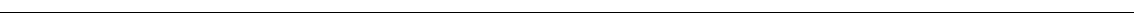
Fig. 5 USP21 stabilizes BRCA2 in HCC cells to promote tumor cell growth. a Western blot analysis of the indicated proteins in the HuH1 hepatoma cell line in the presence or absence of USP21 knockdown. b Western blot analysis and clonogenic survial of HuH1 cells in the presence or absence of BRCA2 knockdown. Colony formation was scored in triplicate and normalized to sh-Luc. Values are expressed as mean and s.d. c Clonogenic survival of HuH1 cells in the presence or absence of USP21 knockdown. Colony formation was scored in triplicate and normalized to sh-Luc. Values are expressed as mean and s.e.m. from three independent experiments. d HuH1 oncosphere formation in the presence or absence of USP21 knockdown. Sphere formation was scored in triplicate and normalized to sh-Luc. Values are expressed as mean and s.d. Representative images are shown, scale bar : 100 µ m. e , f Clonogenic survival e and Western blot analysis f after USP21 depletion in HuH1 cells stably transfected with either empty vector or Flag-BRCA2 (BRCA2-OE). The ef fi ciency of colony formation in sh-USP21 cells was normalized to sh-Luc controls. Samples were analyzed in triplicate, values are expressed as mean and s.d. g Clonogenic survival of CAPAN-1 cells in the presence or absence of USP21 knockdown. Samples are normalized to sh-Luc. Values are expressed as mean and s.e.m. from fi ve independent experiments. A schematic of the CAPAN-1-speci fi c BRCA2 truncation is shown. h HuH1 cell xenograft assay in the absence or presence of USP21. A total of 10 sites were injected per genotype and tumor size was monitored for the indicated time frame. Image and weights are from tumors isolated 6 weeks after injection, scale bar : 1 cm. Values are expressed as mean and s.e.m. p -values are based on Student ’ s two-tailed t -test: * p < 0.05, ** p < 0.01, *** p <